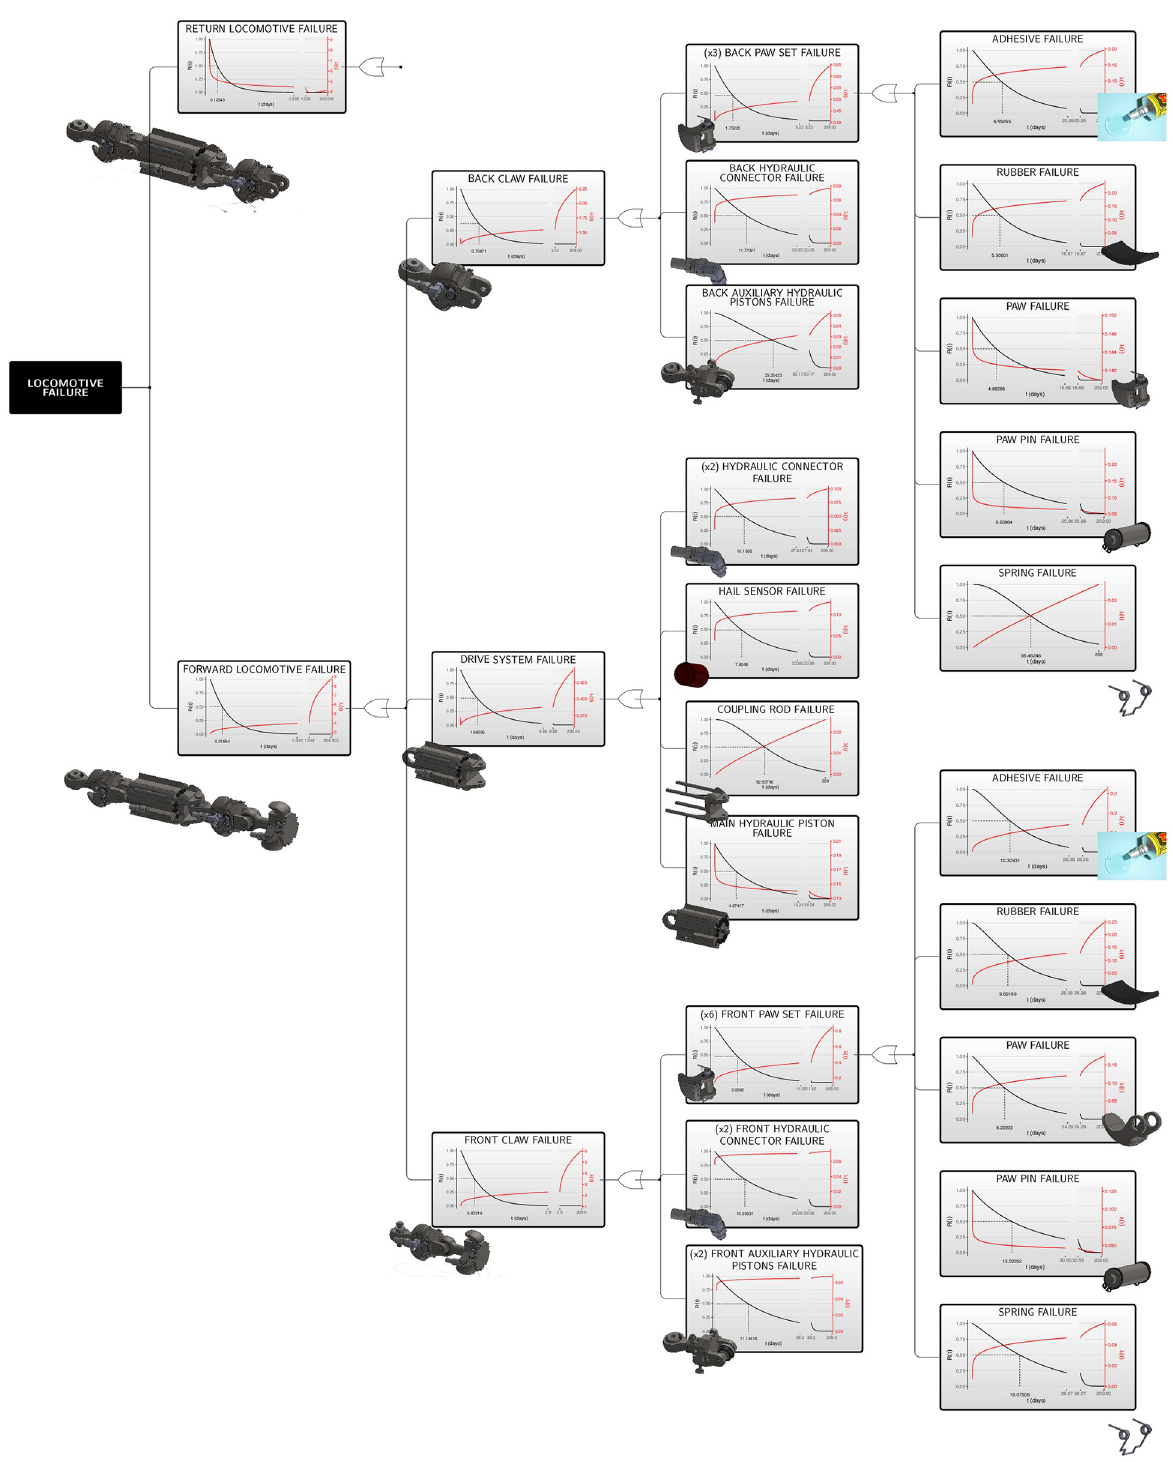
Fig 11. Estimated functions for the in-pipe robotic unit’s traction system. First-failure time reliability (in black) and intensity (in red) functions by components, subsystems and systems.